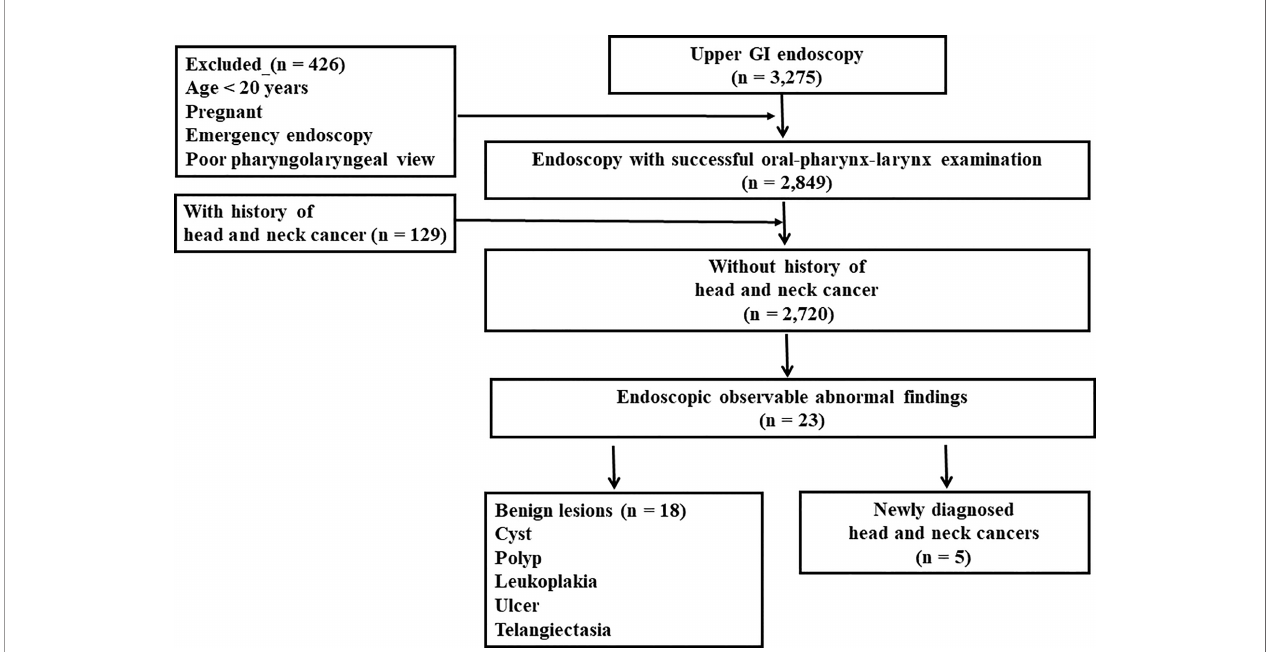
FIGURE 1 | Flowchart of data processing. GI,